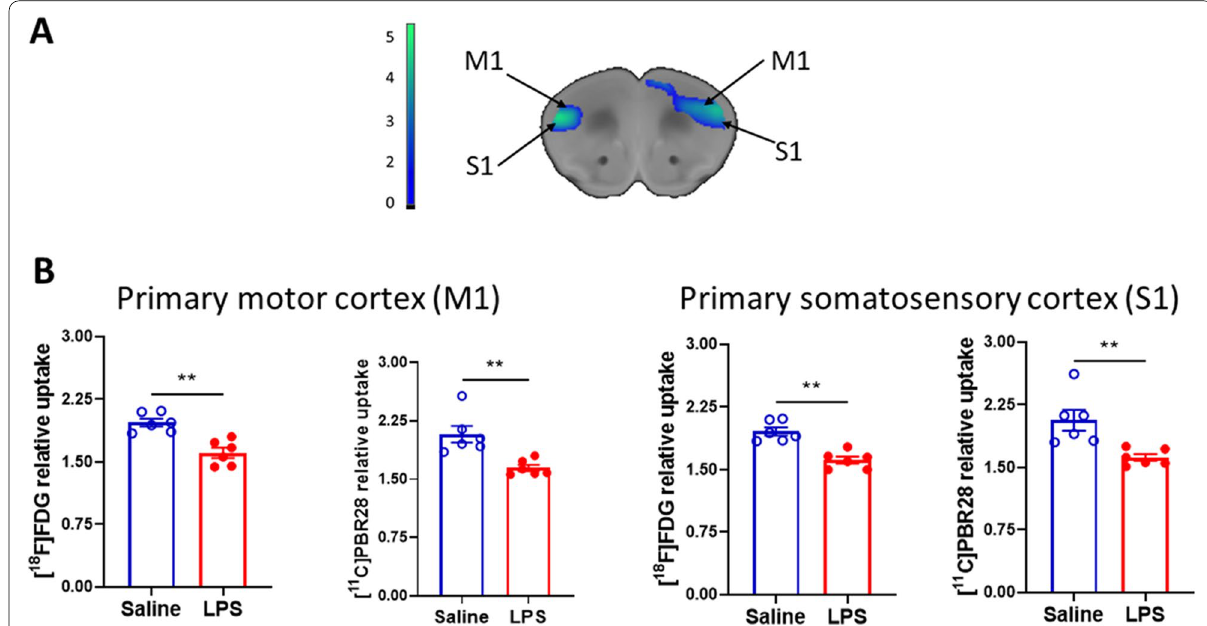
Fig. 3 Brain regions with overlapping significantly decreased [ 11 C]PBR28 and [ 18 F]FDG uptake during endotoxemia. A Simultaneous (dual tracer) uptake decreases in primary and somatosensory motor cortices in LPS administered ( n 6) vs saline administered ( n 6) mice. Dual tracer = = decreases in metabolism and TSPO binding shown with SPM cluster overlaid onto MRI atlas for visualization (color bar represents t‑value height, cutoff threshold T 2.85). B Individual [ 18 F]FDG and [ 11 C]PBR28 decreases in primary and somatosensory motor cortices were subjected to post‑hoc = analysis in the same groups (saline, n 6 and LPS, n 6) of mice. ** P 0.002. See Methods for = = =